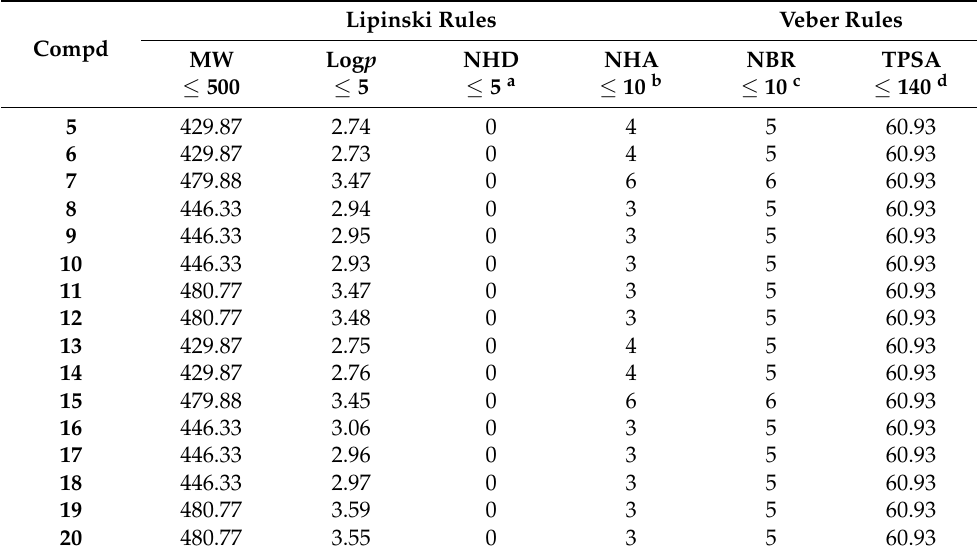
Table 1. Drug-likeness parameters according to Lipinski and Veber rules.